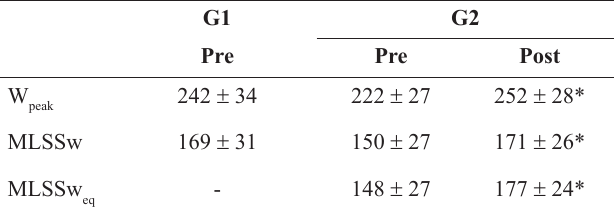
* Different from pre-training ( p